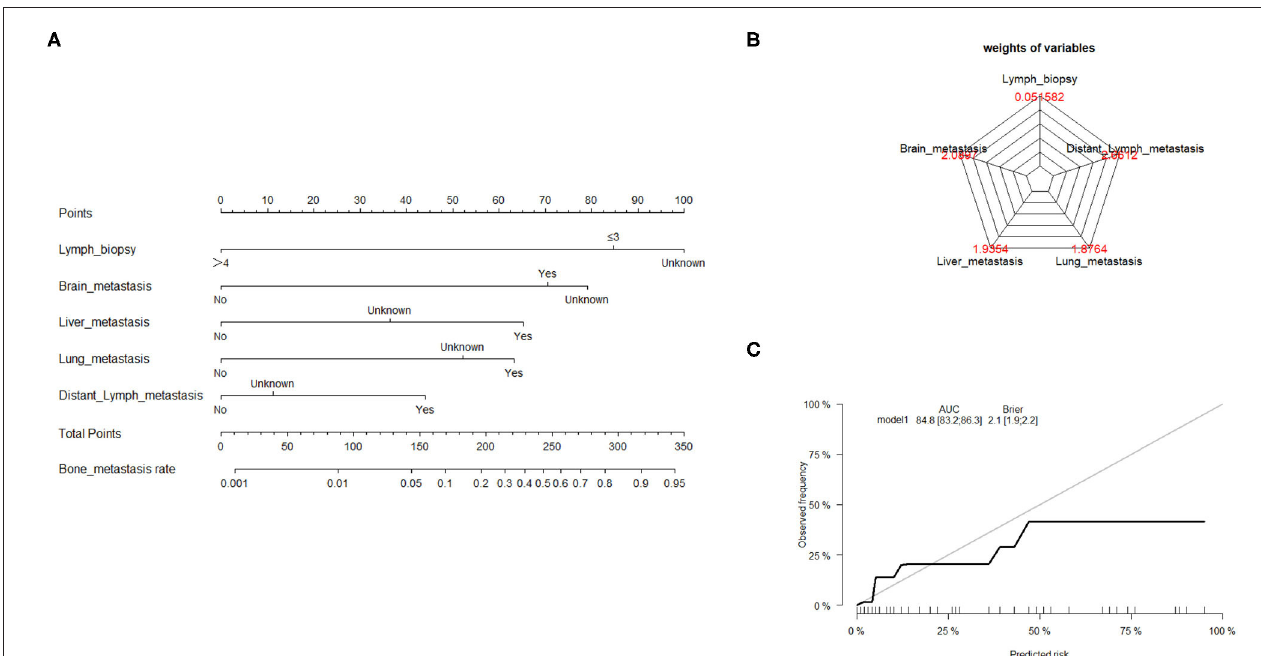
FIGURE 2 | Nomogram to estimate the risk of bone metastasis. (A) A nomogram for predicting the risk of bone metastasis showing the proportion (%) of parameters included in the score scale. To use the bone metastasis nomogram score, it is important to identify the point of each variable on the corresponding axis; the total number of points can then be summated from all variables. (B) Radar plot showing the relative weight of candidate parameters arising from stepwise regression analysis. (C) Calibration curves depicting the robust performance of the nomogram in terms of consensus between the predicted risk and actual risk